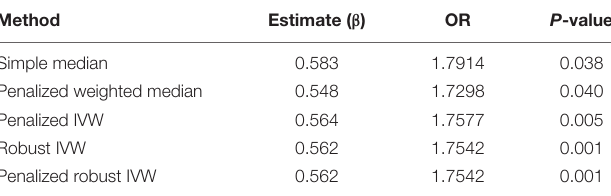
TABLE 2 | Five other MR methods to analyze the